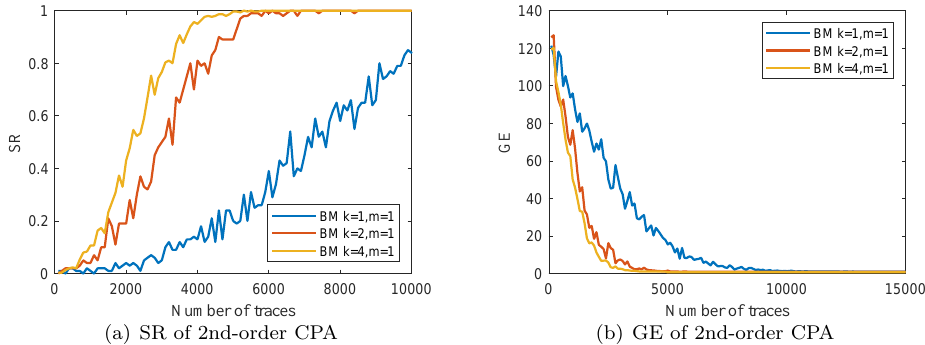
Figure 7: SR and GE results of 2nd-order CPA for BM instances on packed